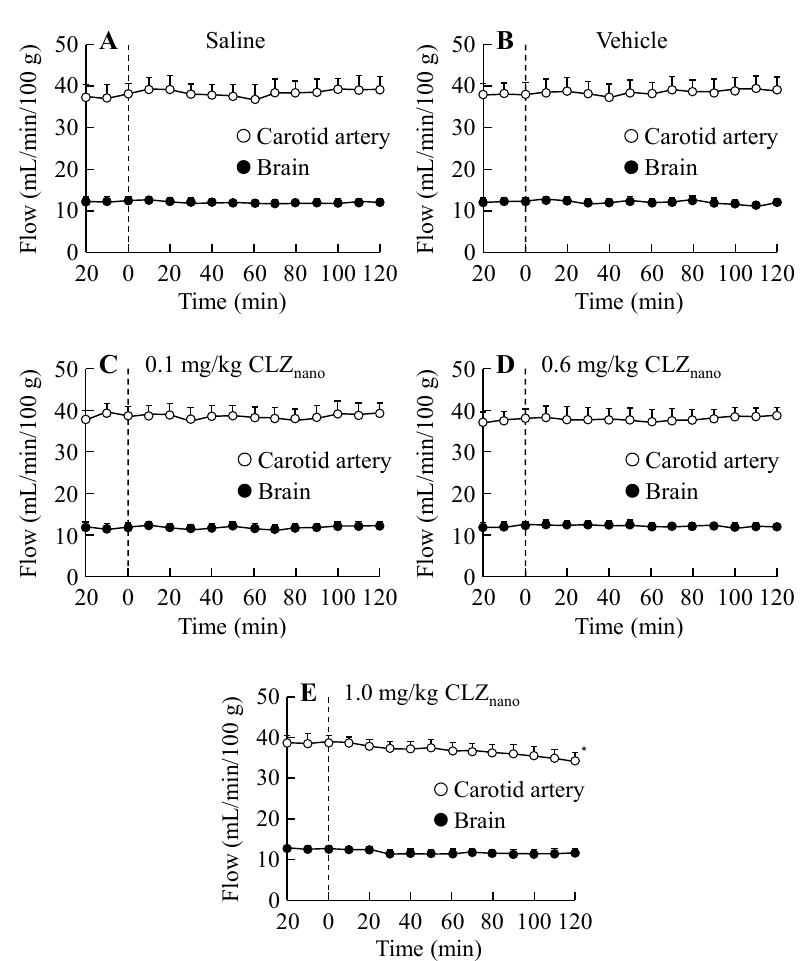
Figure 5. Changes in blood flow following the intravenous injection of CLZ nano dispersion. Saline ( A ); vehicle ( B ); 0.1 mg/kg CLZ nano ( C ); 0.6 mg/kg CLZ nano ( D ) or 1.0 mg/kg CLZ nano ( E ) dispersion was injected into the tail vein. The rats were anesthetized with Urethane (1.2 g/kg, i.p.), and the blood flow in the carotid artery (open circles) and brain (closed circles) were measured using a non-contact type laser doppler flowmeter (OMEGA Flow FLO-N1). CLZ was injected 20 min after the first measurement (0 min). The data are presented as means ± S.E. of seven independent rats. * p < 0.05, vs. blood flow at 0 min for each category.